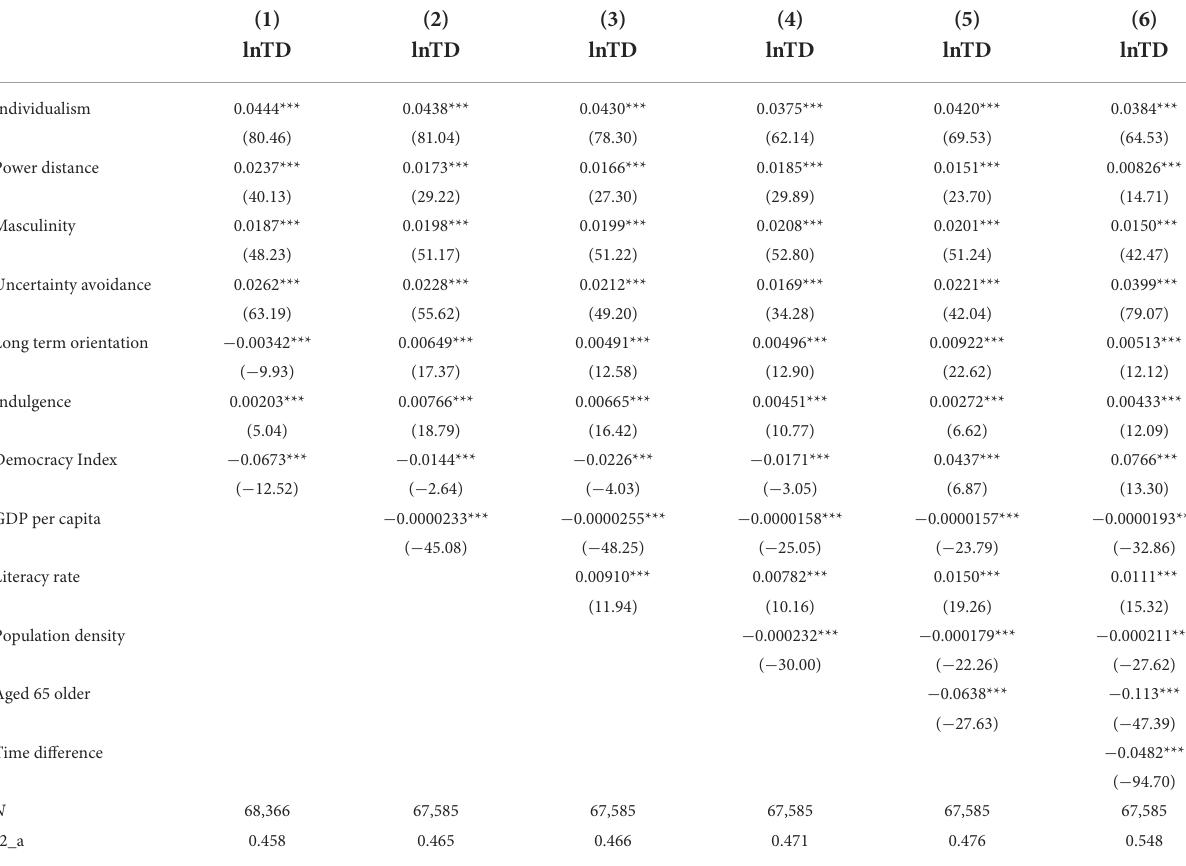
TABLE 3 Impact of 6 culture dimensions on total deaths.